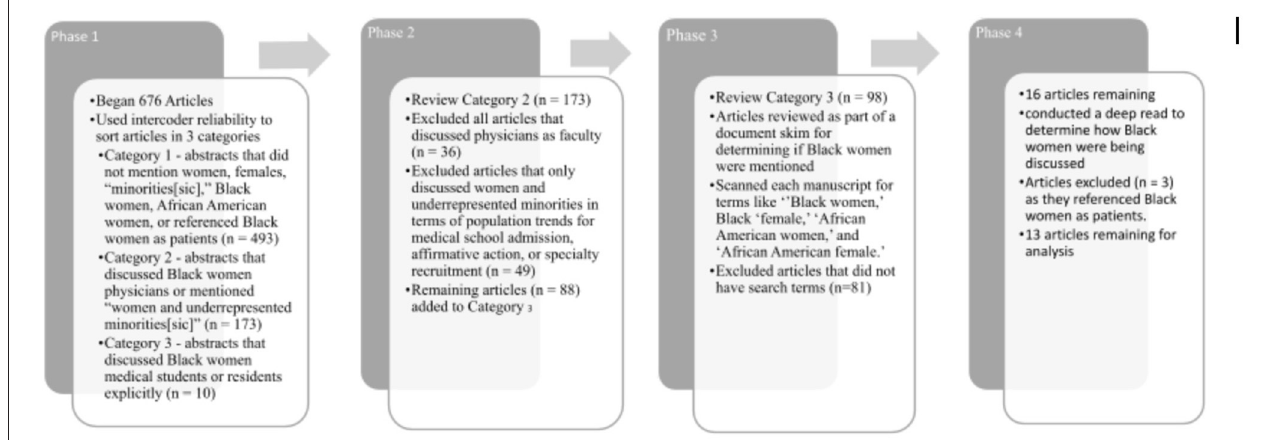
FIGURE 1 | Study selection